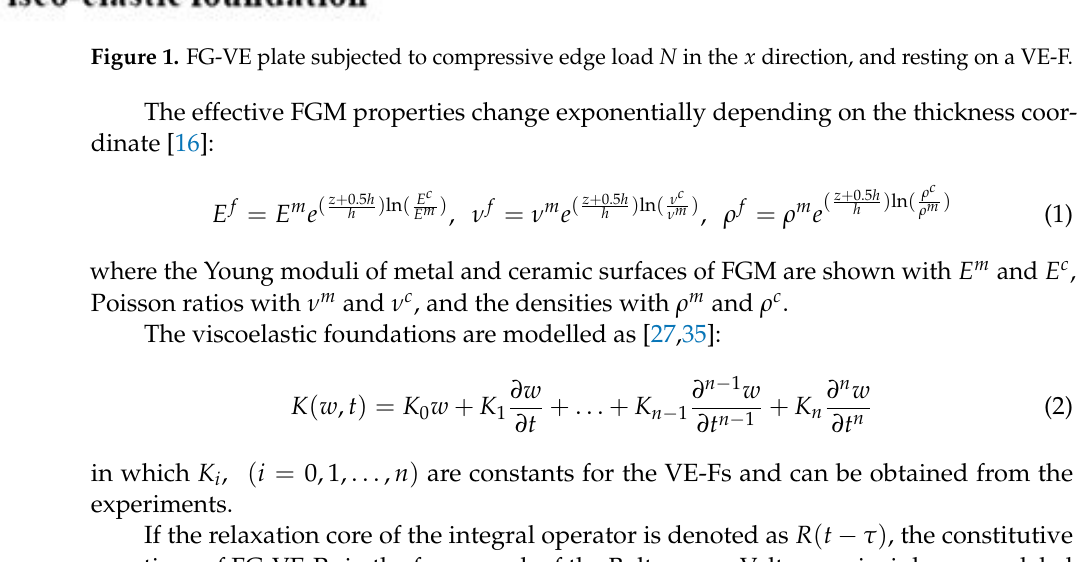
Figure 1. FG-VE plate subjected to compressive edge load N in the